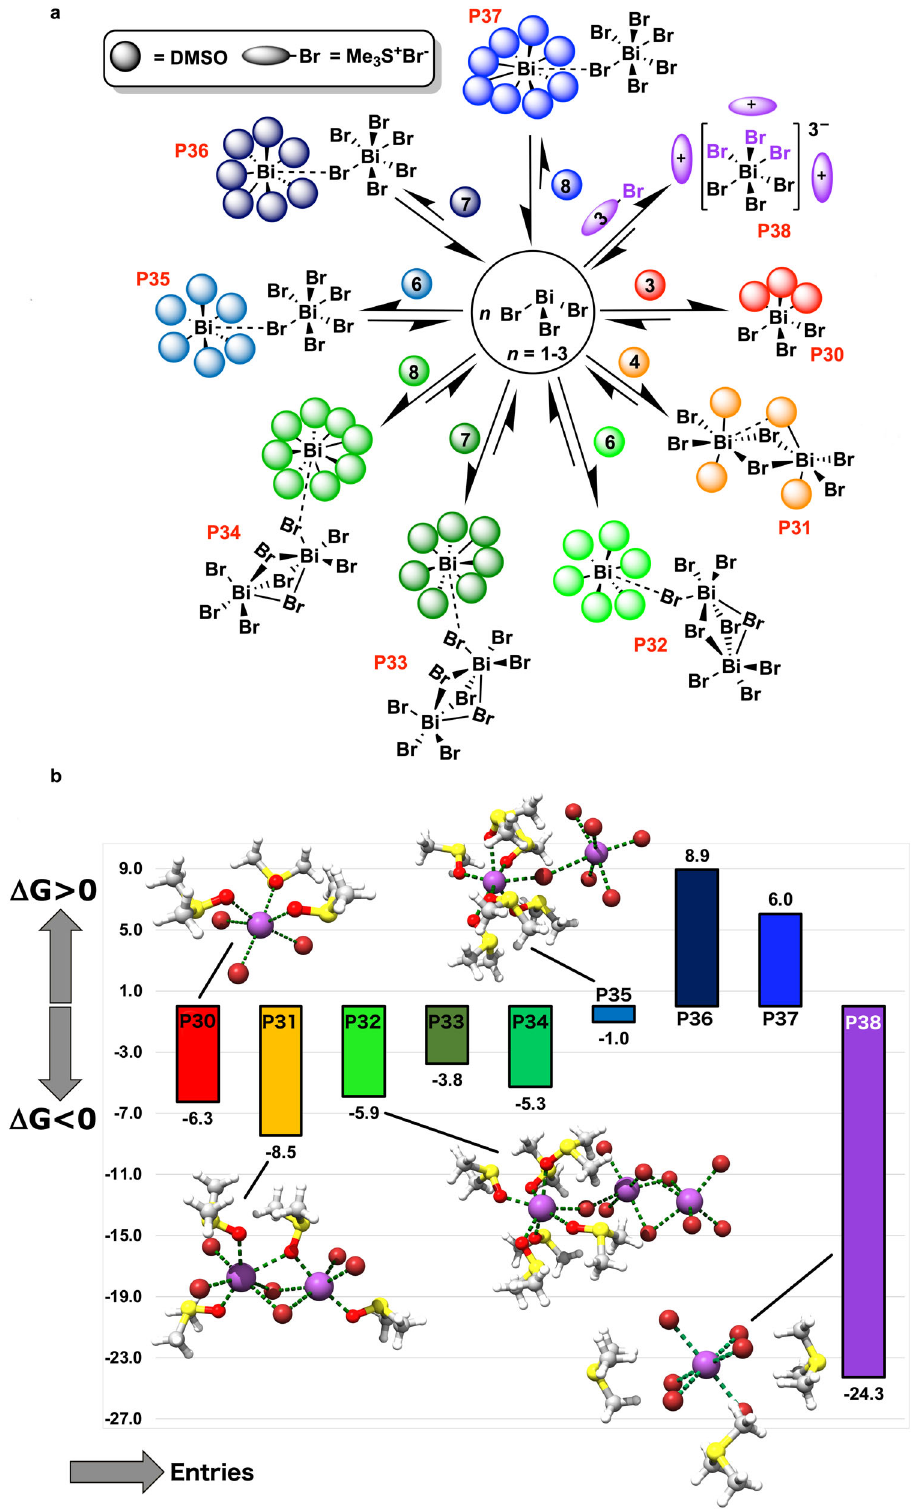
Fig. 7 Improving the realism of the model: solvation of BiBr 3 versus complexation with (Me 3 S)Br. a General reaction scheme for solvation of naked BiBr 3 with dimethyl sulfoxide (sketched as a sphere for clarity) or complexation with (Me 3 S)Br (sketched as an ellipsoid for clarity), the salt formed via Kornblum – Hess degradation of DMSO in presence of DEBM. b Free energy of formation ( Δ G 0 ) of DMSO-adducts (P30 – P37) and {[(Me 3 S) 3 ][BiBr 6 ]} adduct (P38) at 298 K and 1 M standard state. The data are in kcal mol − 1 per equivalent of bismuth. Relevant molecular structures are overlaid within the graph (Bi in purple, Br in dark red, O in bright red, S in yellow, C in gray, and H in